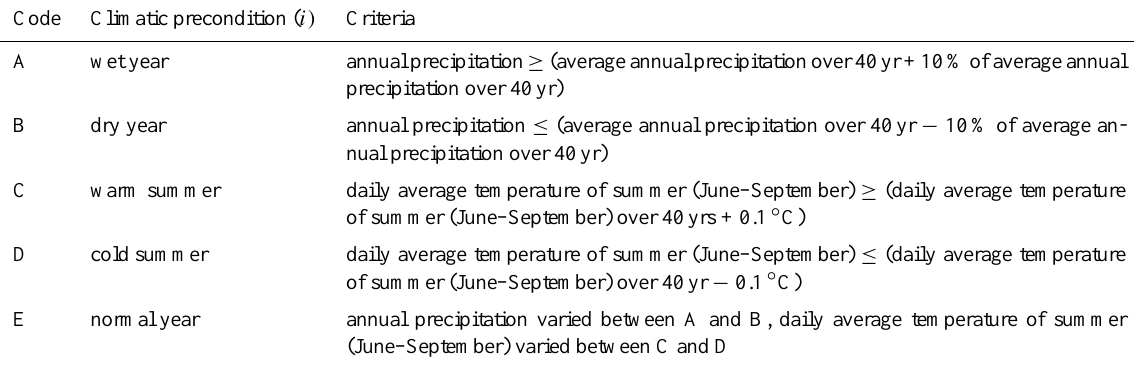
Table 3. Climatic preconditions causing moraine-dam failure and the discriminating criteria. Code Climatic precondition ( i)